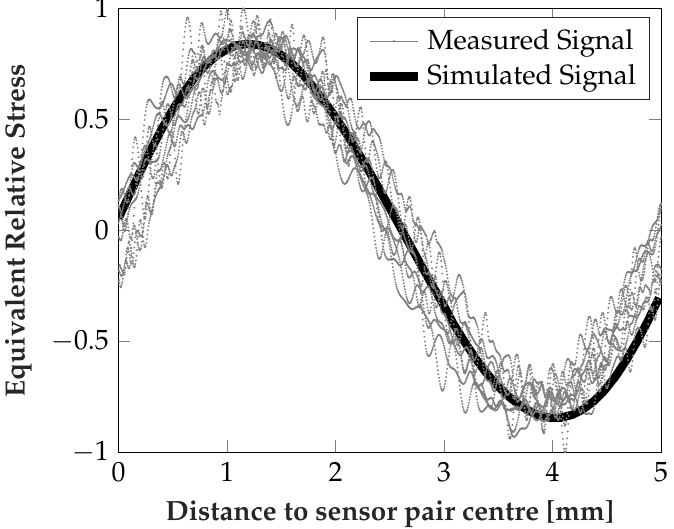
Figure 10. Simulated and measured difference signal at 50 kN with moving runner block for 100 mm.